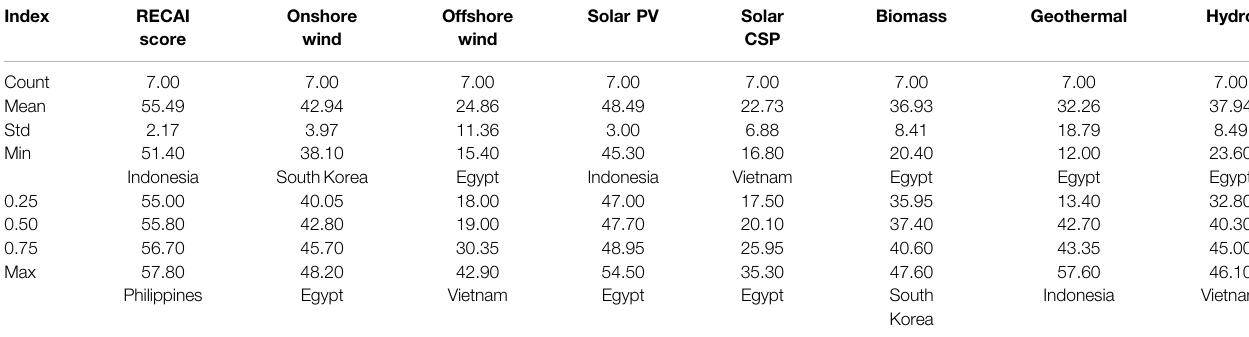
TABLE 9 | Descriptive statistics with technological speci fi c scores of N-11